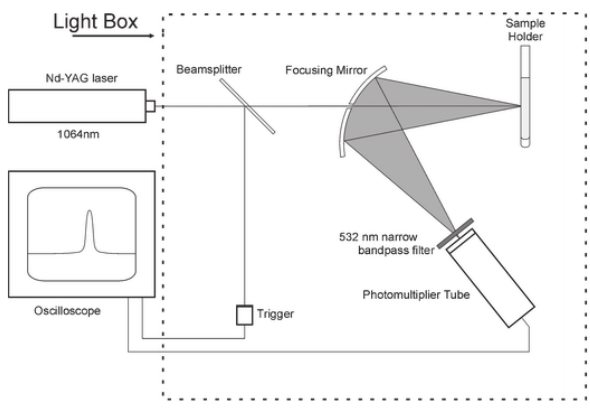
Figure 1: Second Harmonic Generation (Kurtz-Perry Method).